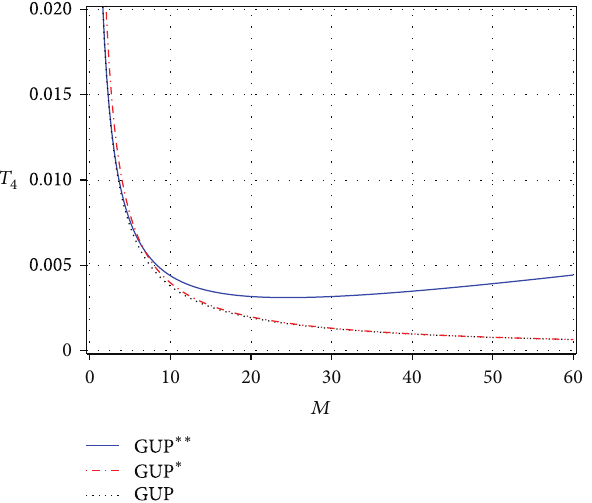
Figure 5: Temperature of black hole as a function of mass for 𝑑 = 4 and with three different types of GUPs.